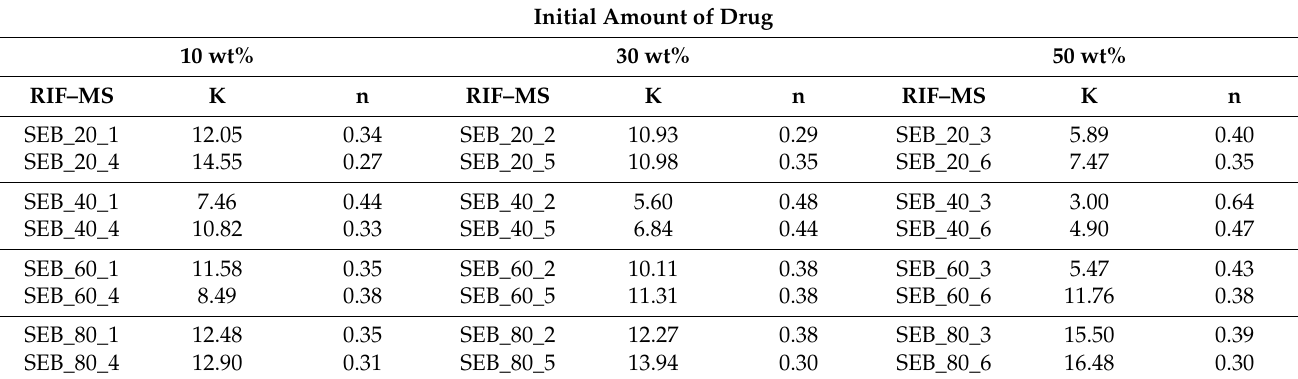
Table 9. Kinetic parameters K and n for RIF–MS, calculated according to Equation (20). Initial Amount of